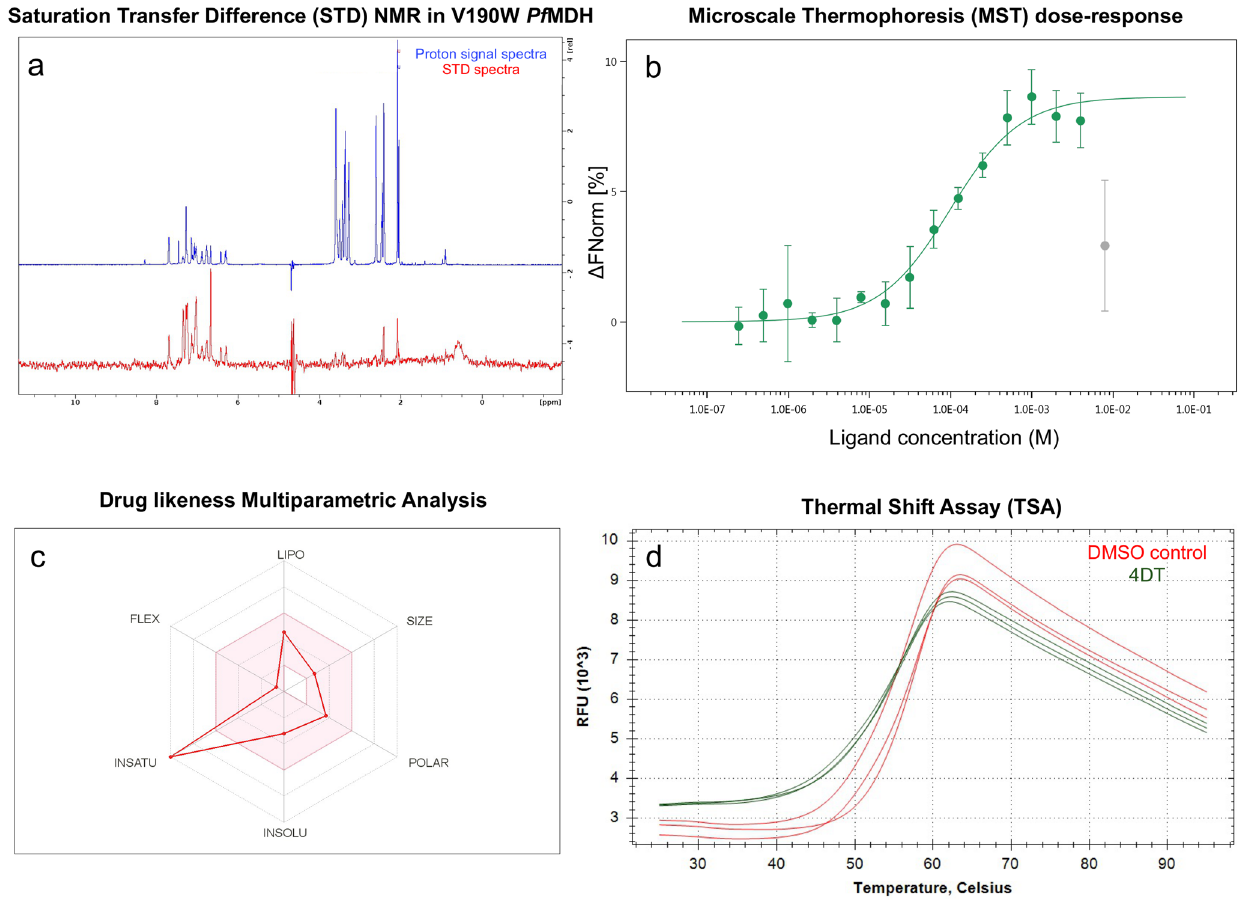
Fig. 1 Biophysical characterization of 4DT. a STD-NMR, b MST validation with fl uorescently labeled WT Pf MDH, and c drug-likeness pro fi le from SwissADME 61 . The pink area represents the optimal range for each property (lipophilicity: XLOGP3 between − 0.7 and + 5.0, size: MW between 150 and 500 g/mol, polarity: TPSA between 20 and 130 Å 2 , solubility: log S not higher than 6, saturation: fraction of carbons in the sp3 hybridization not less than 0.25, and fl exibility: no more than 9 rotatable bonds. d Thermal destabilization of Pf MDH in presence of 4DT (red lines) and control group (green lines) as measured by TSA experiments. RFU relative fl uorescence units. Data are represented as mean ± SEM ( n = 3 biologically independent